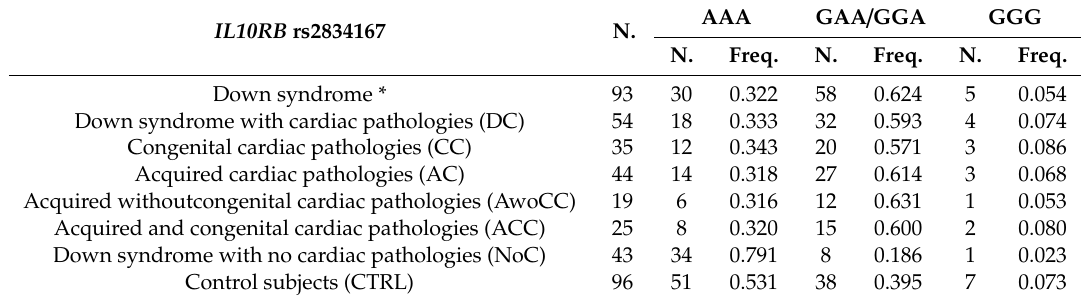
Table 7. IL10RB rs2834167 genotype frequencies of patients with DS and controls. IL10RB rs2834167 N.